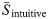
Heat map of normalised similarities S¯intuitive between pairs of movies.Evident are blocks of movies corresponding to the major sub-sequences, e.g., the Thor movies or the Iron Man movies. Also noticeable is the sharing of cast between the Avengers (team-up) movies and many of the others.